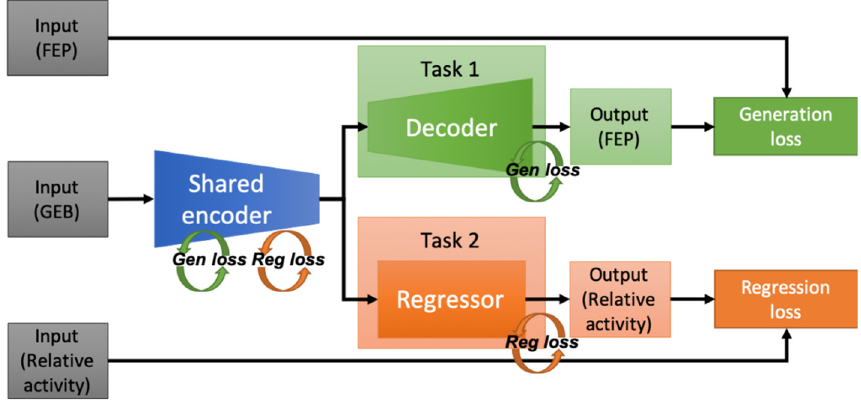
Figure 1. Configuration of the baseline model.